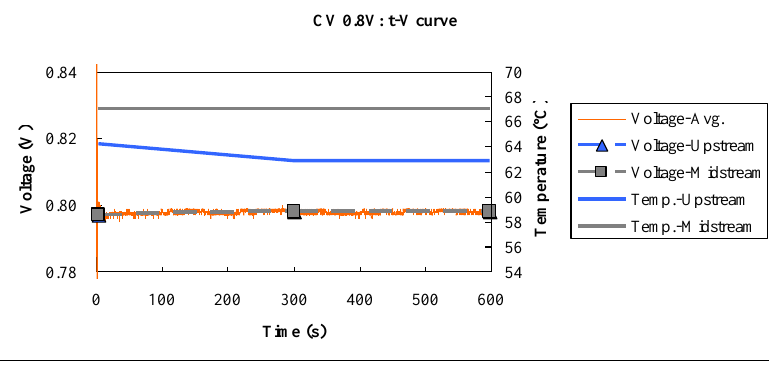
Figure 9. Voltage and temperature difference at constant voltage 0.8 V. CV 0.8V: t-V curve